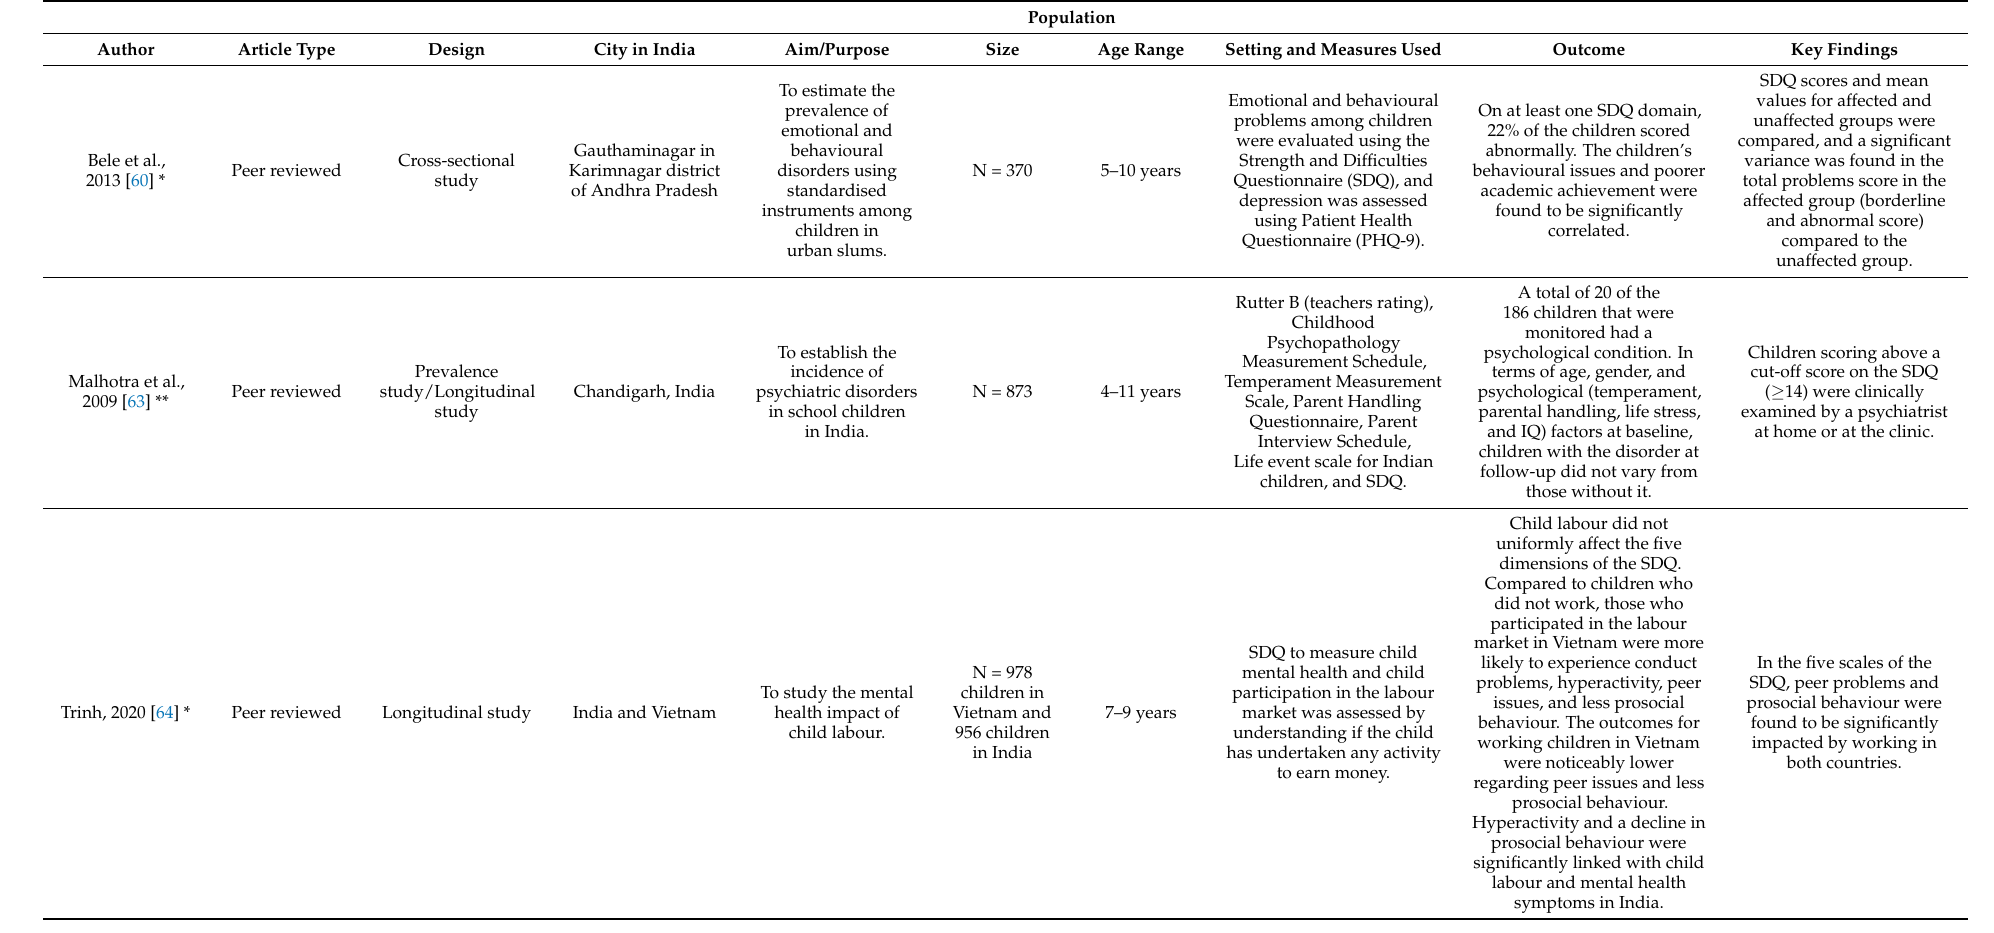
Table 2. Summary of studies on the Strength and Difficulties Questionnaire (SDQ) use in